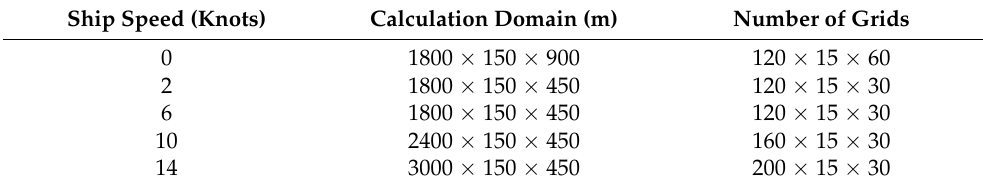
Table 3. Calculation domains and the number of grids for different ship